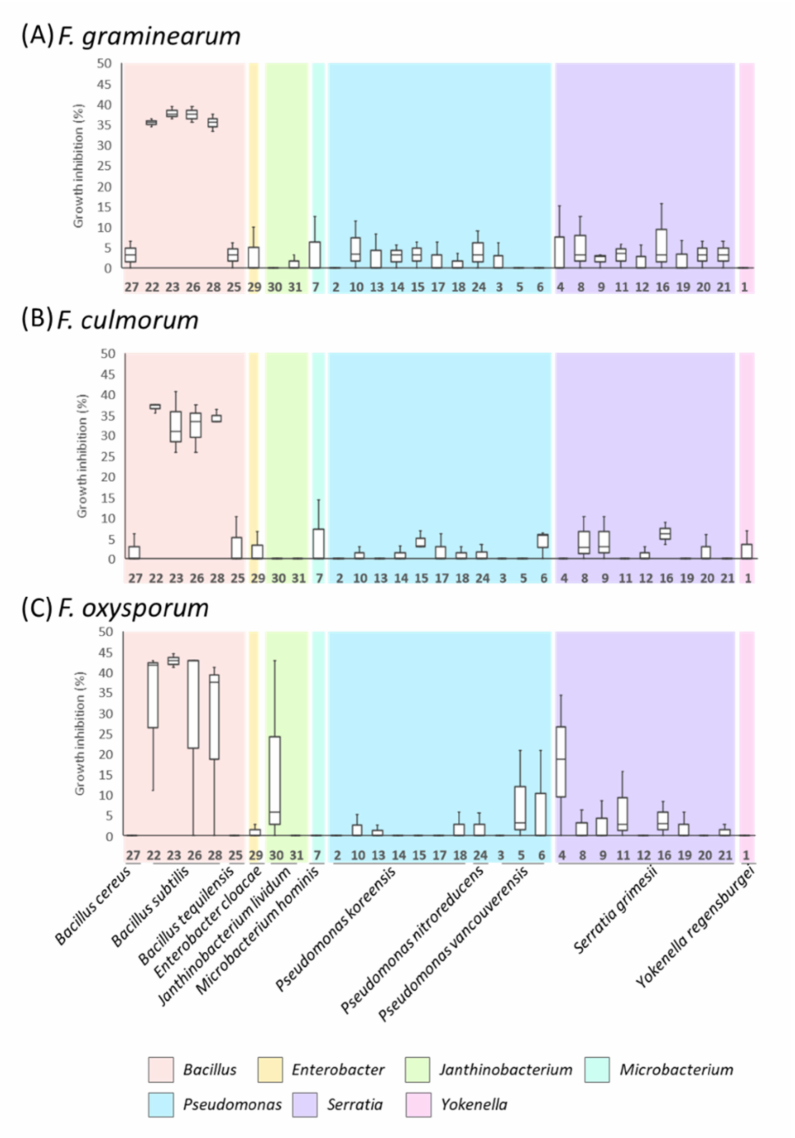
Figure 3. Growth inhibition rates of the cell-free supernatants of vetiver endophytic bacteria grown in KB medium against F. graminearum ( A ), F. culmorum ( B ), and F. oxysporum ( C